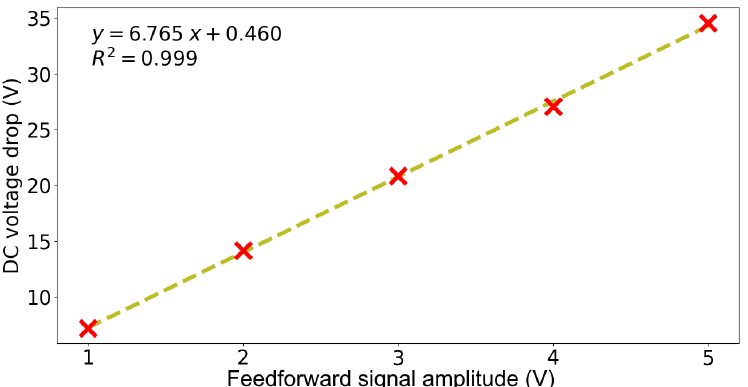
Figure 9. Relation between system voltage drop and feedforward signal amplitude for Cloud 1.